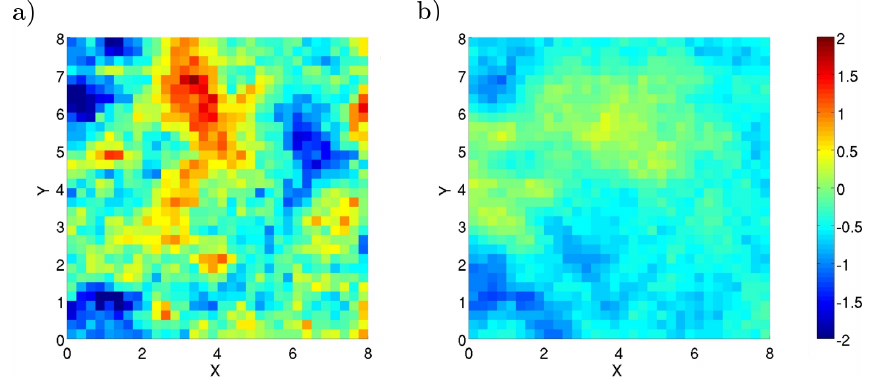
Fig. 6. Scenario 3: log-transformed hydraulic conductivity field retrieved by (a) the EnKF and (b) ES using normal-score-transformed concentration data. The color bar indicates log-transformed hydraulic conductivity in ln (L/T ).